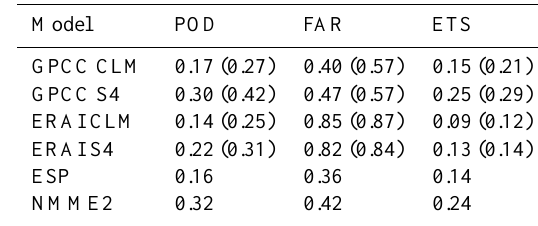
Table 2. Global mean values of probability of detection (POD), false alarm ratio (FAR) and equitable threat score (ETS) for drought onset forecasts. The scores between brackets were calculated af- ter scaling the ensemble mean. The 95% confidence intervals, esti- mated from 1000-sample bootstrapping with replacement, returned similar values for all scores and models of approximately ± 0 . 01. The ESP and NMME2 model scores are included in this table for comparison purposes only and were retrieved from Yuan and Wood (2013, see Table